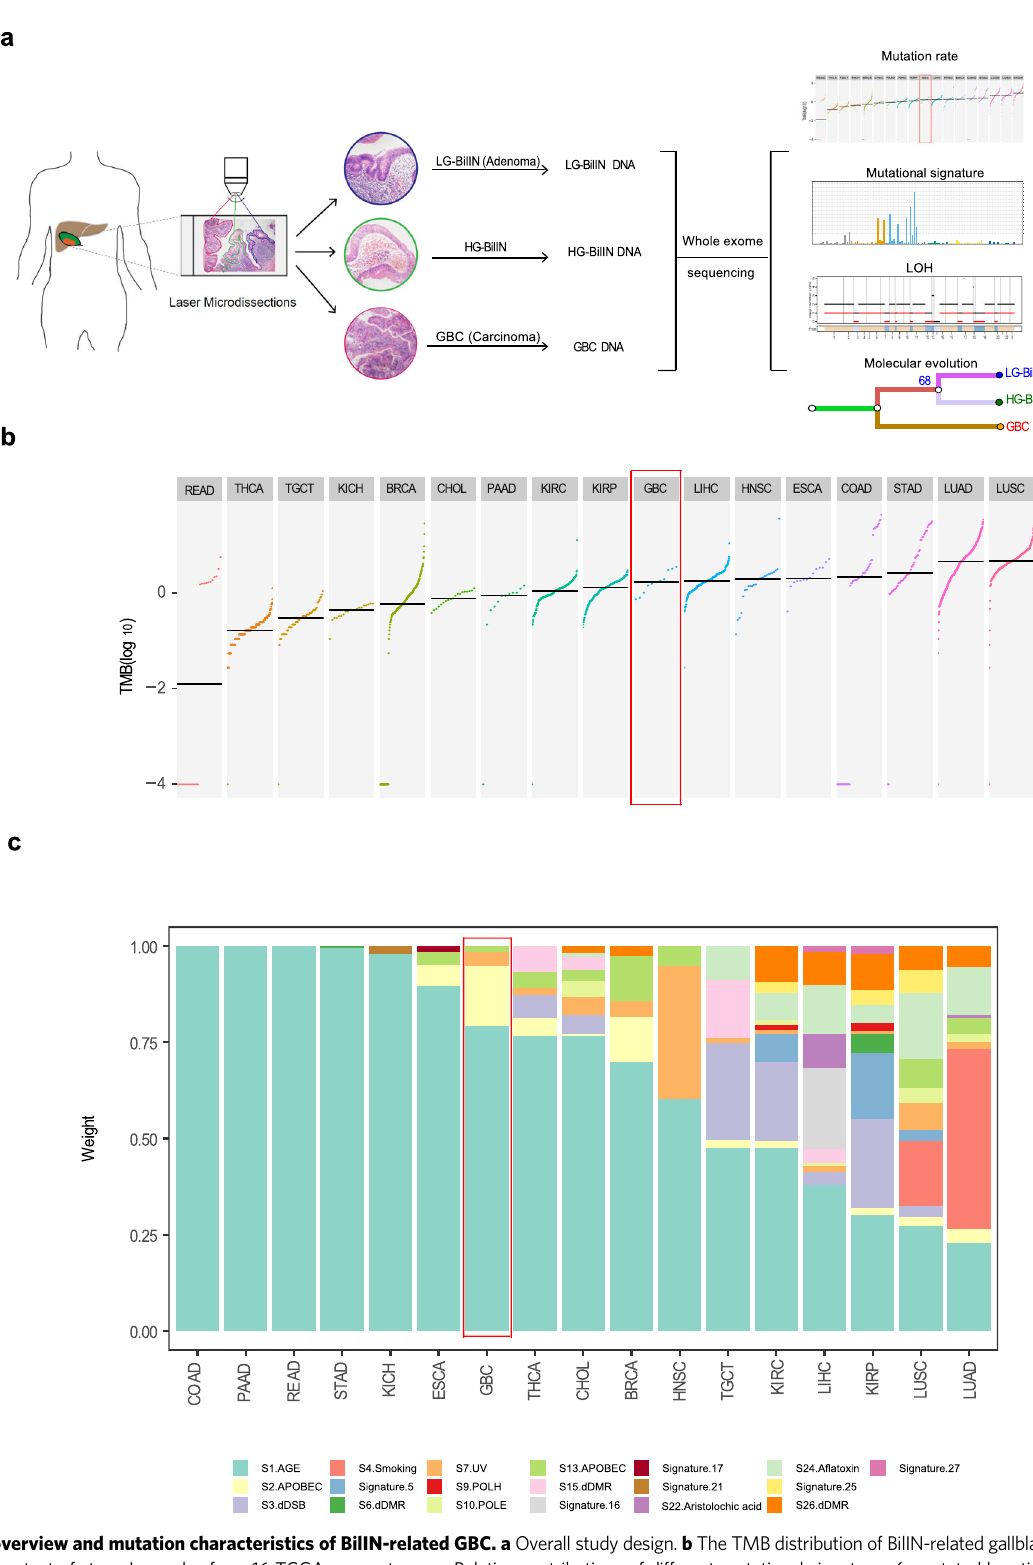
NATURE COMMUNICATIONS| (2021) 12:4753 |https://doi.org/10.1038/s41467-021-25012-9|www.nature.com/naturecommunications